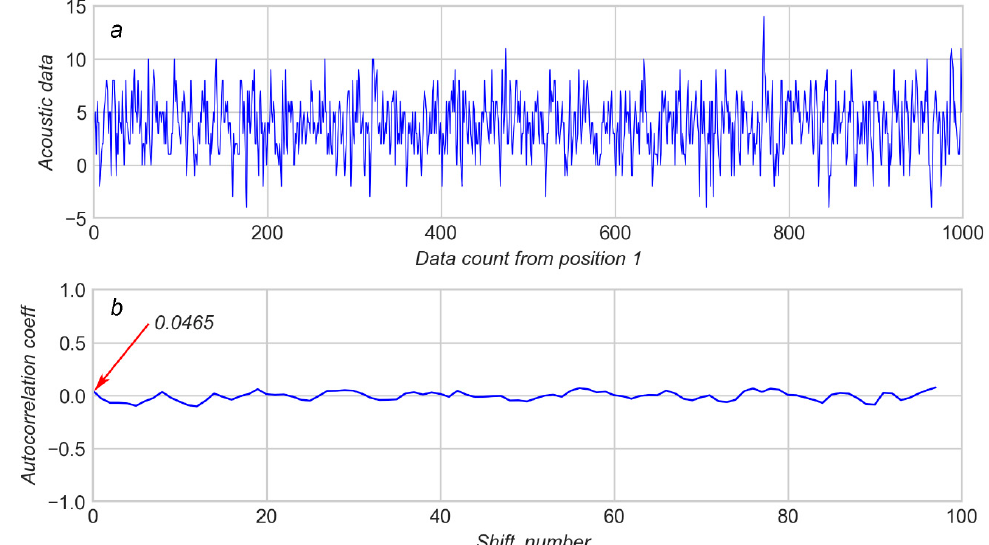
Figure 4. ( a ): The 1000 K window of acoustic data from arrow 1 (see Figure 1); ( b ): corresponding autocorrelation coefficients. autocorrelation coe ffi cients.